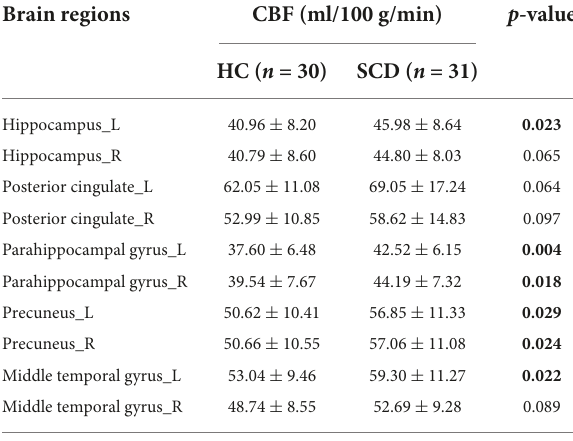
TABLE 2 Differences in CBF of cognition-related brain regions between the two groups. Brain regions